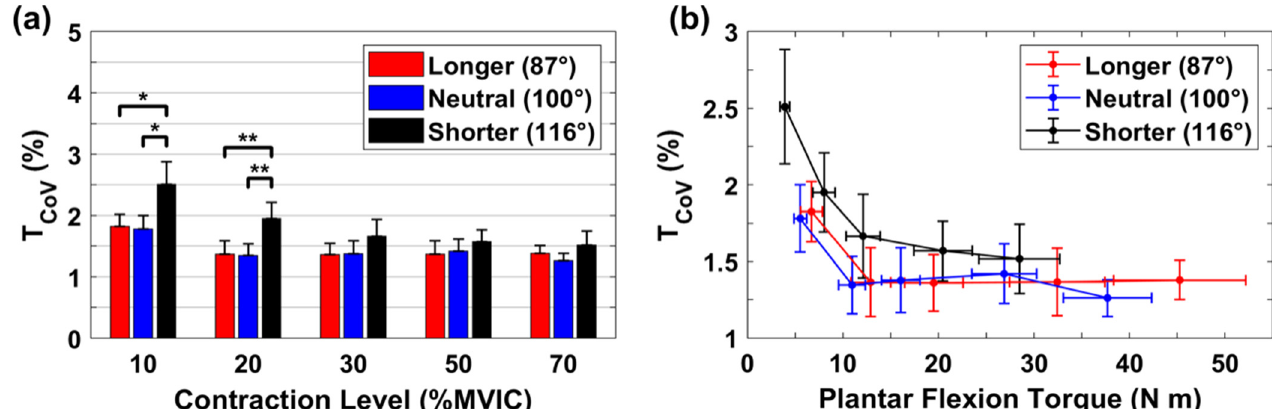
Figure 4. ( a ) Relative torque variability at different contraction levels and joint angles. ( b ) Relative torque variability at different plantar flexion torque and joint angles. Asterisk indicates a significant difference (* p < 0.050, ** p < 0.001) detected between different muscle lengths. T CoV indicates the relative torque variability. Error bars indicate SEM.